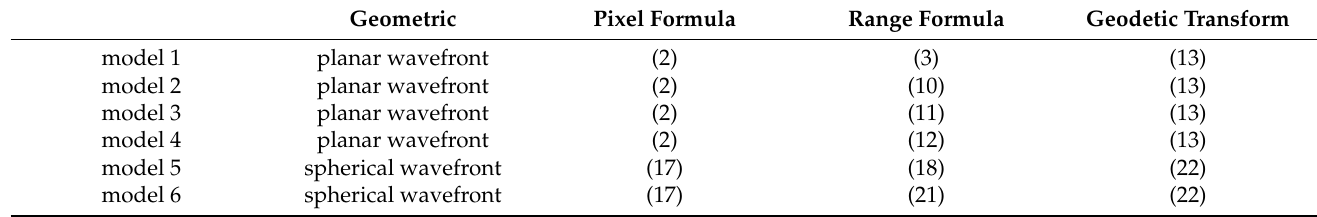
Table 1. Details of